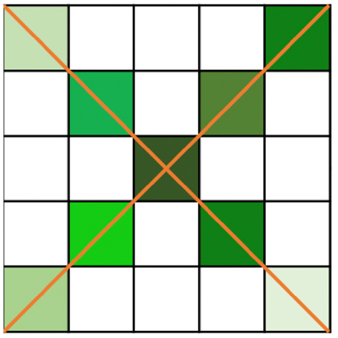
Figure 5. The attention area of RCCA module .